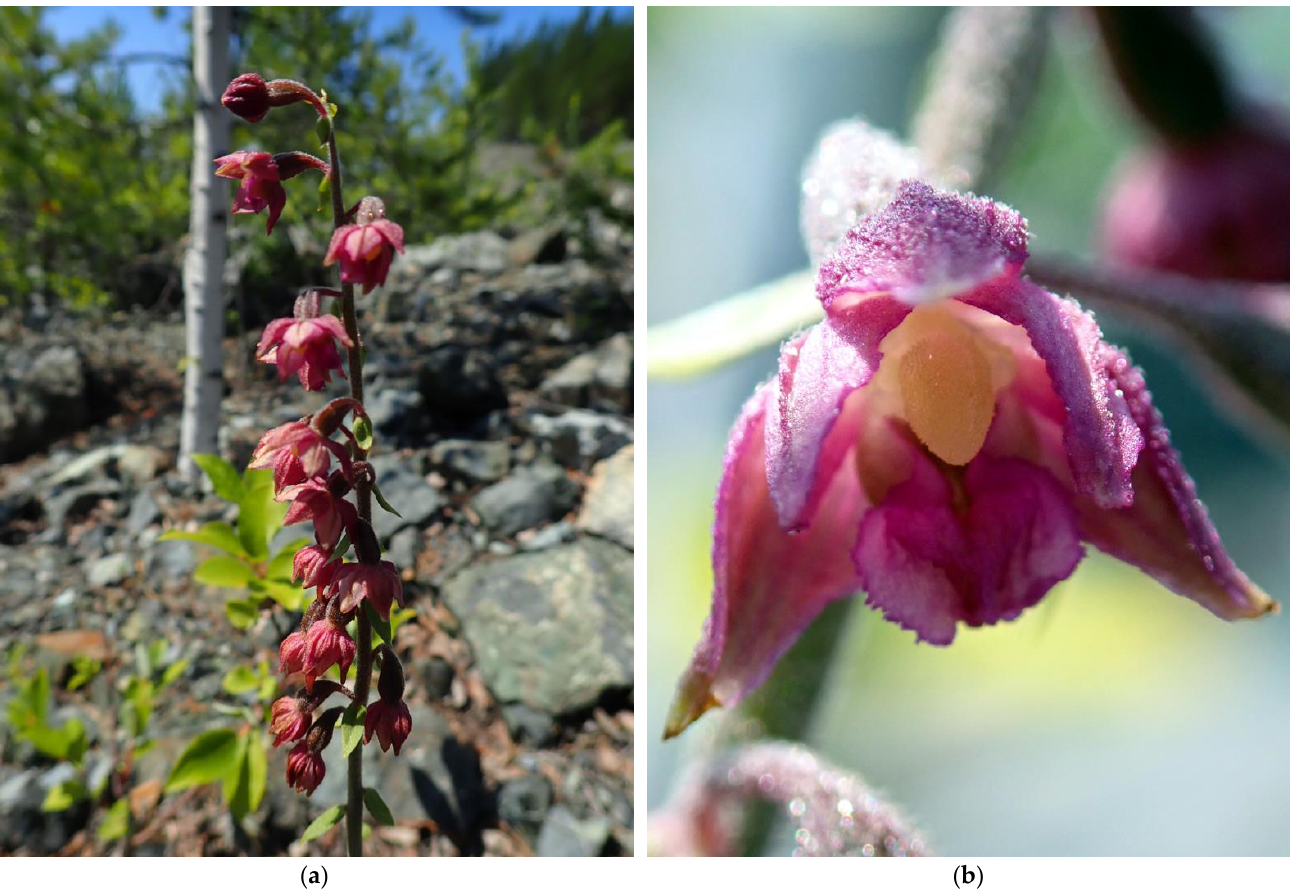
Figure 1. Epipactis atrorubens on serpentine dump: ( a ) Flowering plant; ( b ) Orchid flower.